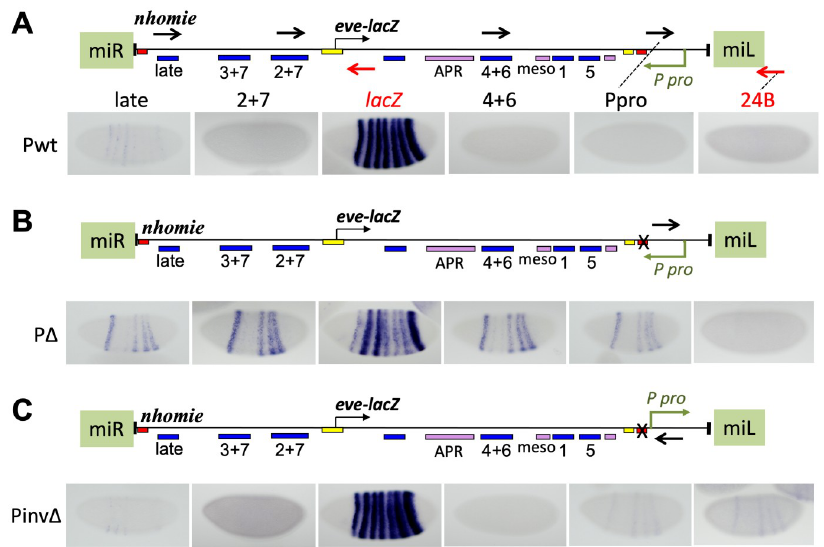
Fig 4. Inserting a flanking P-element promoter induces non-coding transcription, and if it causes read-through, repression of expression from the eve promoter. eve-lacZ and non-coding RNA expression in stage 5 embryos from eve pseudo-loci flanked by a 5’ P-element promoter ( P-pro ), inserted in the orientation diagrammed, at a MiMIC site (cytological location 24B1). The 3 loci (map above each one) differ only in the presence ( A , Pwt) or absence ( B , P Δ and C , Pinv Δ ) of homie (red box near P-pro ), and in the orientation of P-pro (pointing to the left in A and B, and to the right in C). Positions and orientations of the RNA probes are shown as black and red arrows in the map in A (and in B and C for the probe closest to P-pro ). Embryos were stained with the probes listed above in A, using either black lettering corresponding to black arrows in the map (detecting transcription from right to left), or red lettering corresponding to red arrows (detecting transcription from left to